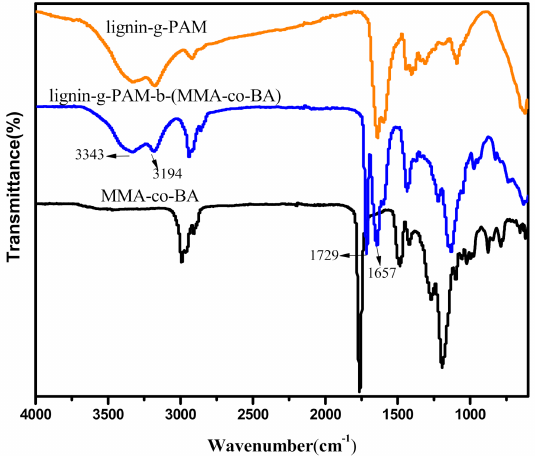
Figure 4. ATR-FTIR spectra of pure MMA- co -BA, lignin-grafted hybrid acrylate copolymer, and